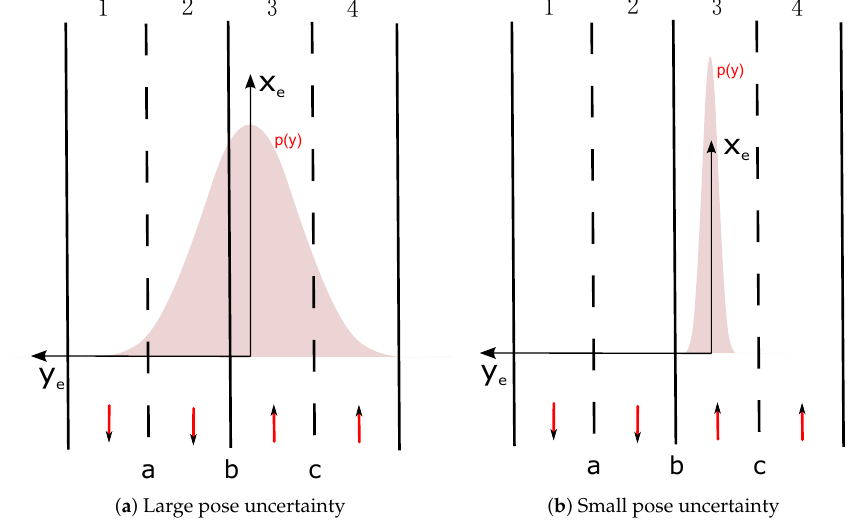
Figure 5. Examples of pose uncertainty and lane belief distribution.